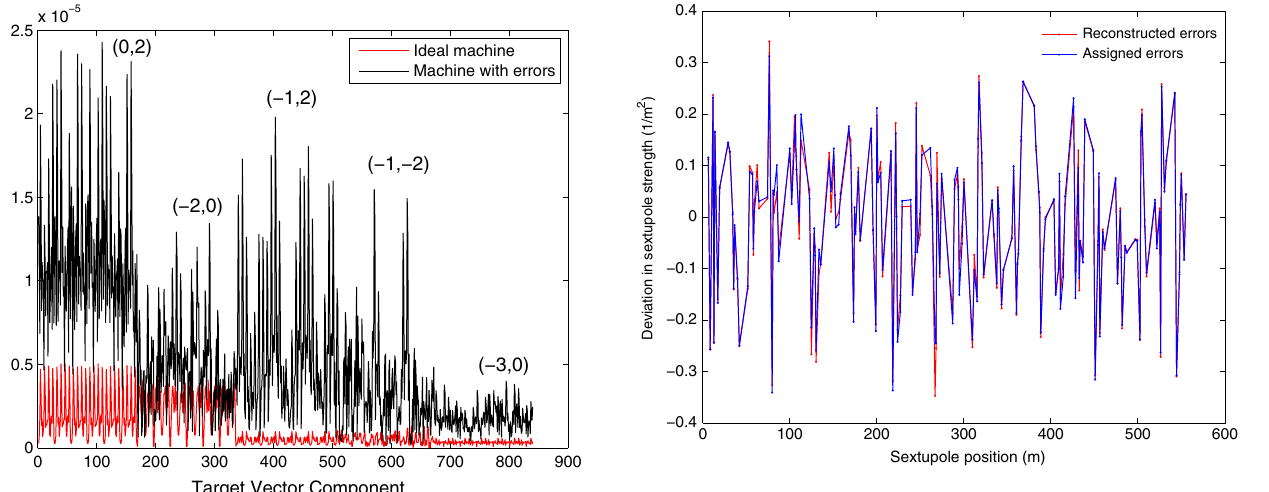
FIG. 1. (Color) Comparisons of the target vector built with the amplitude of five spectral lines (0, 2), ð(cid:1) 2 ; 0 Þ , ð(cid:1) 1 ; 2 Þ , ð(cid:1) 1 ; (cid:1) 2 Þ , ð(cid:1) 3 ; 0 Þ in the horizontal plane for the nominal model for the Diamond bare lattice (red) and for the machine model with the assigned random errors in the sextupole